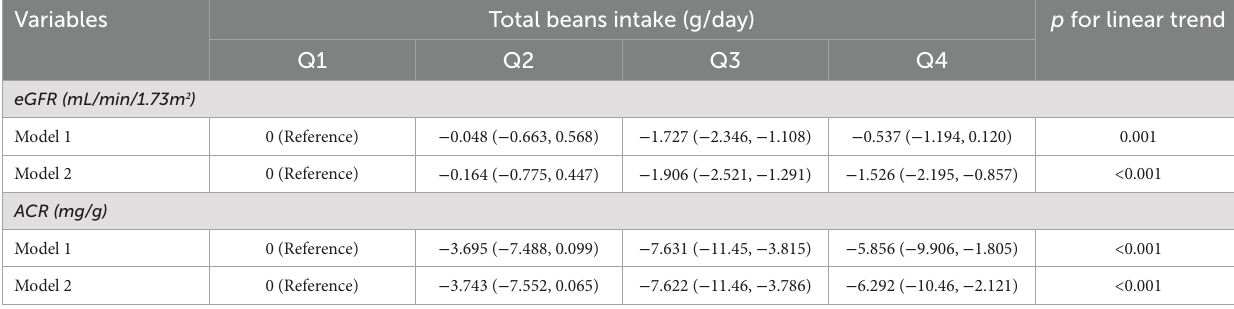
TABLE 2 Multivariable-adjusted β -coefficients and 95% CI for eGFR and ACR according to quartiles of total beans intake. Variables